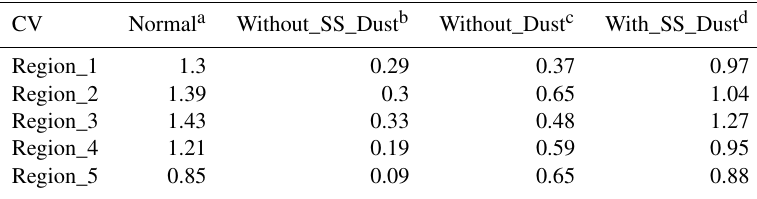
Table 3. The CV (standard deviation divided by the mean) of simulated coarse particles (subtract PM 2 . 5 from PM 10 ) in each defined subregion.